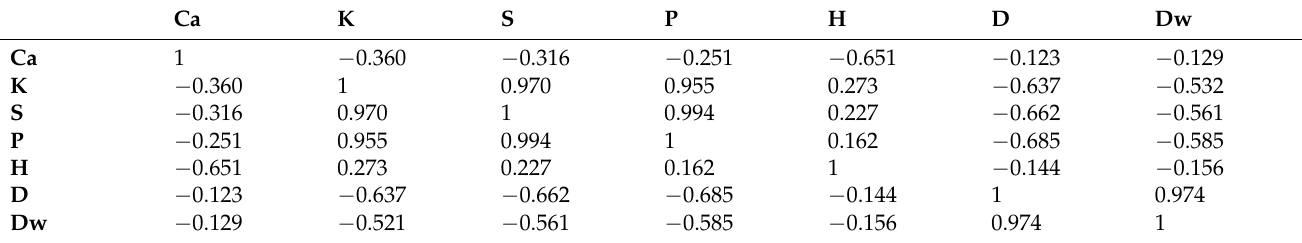
Table 3. Pearson’s correlation between Ca, K, S, P, height, diameter, and dry weight content in tubers after the last foliar application for the Agria variety. Height (H); Diameter (D) and Dry weight